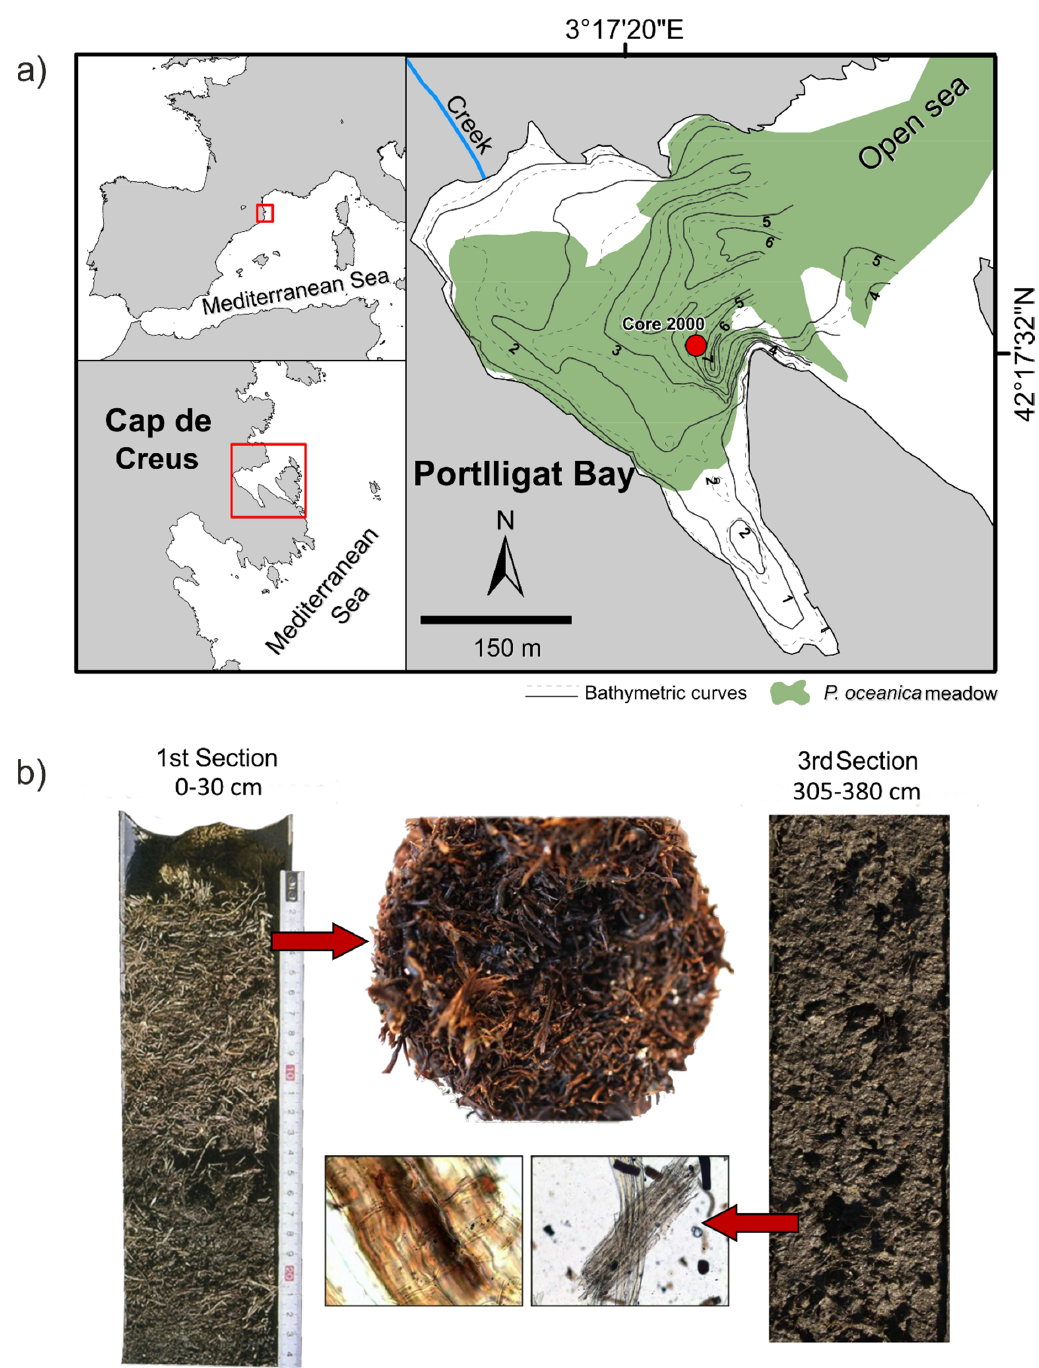
Figure 1. ( a ) Coring site of the P. oceanica soil core in Portlligat Bay (Girona, Spain); ( b ) detail of the upper and lower sections of the core, where plant fibers can be found. Modified from Leiva-Dueñas (2018)